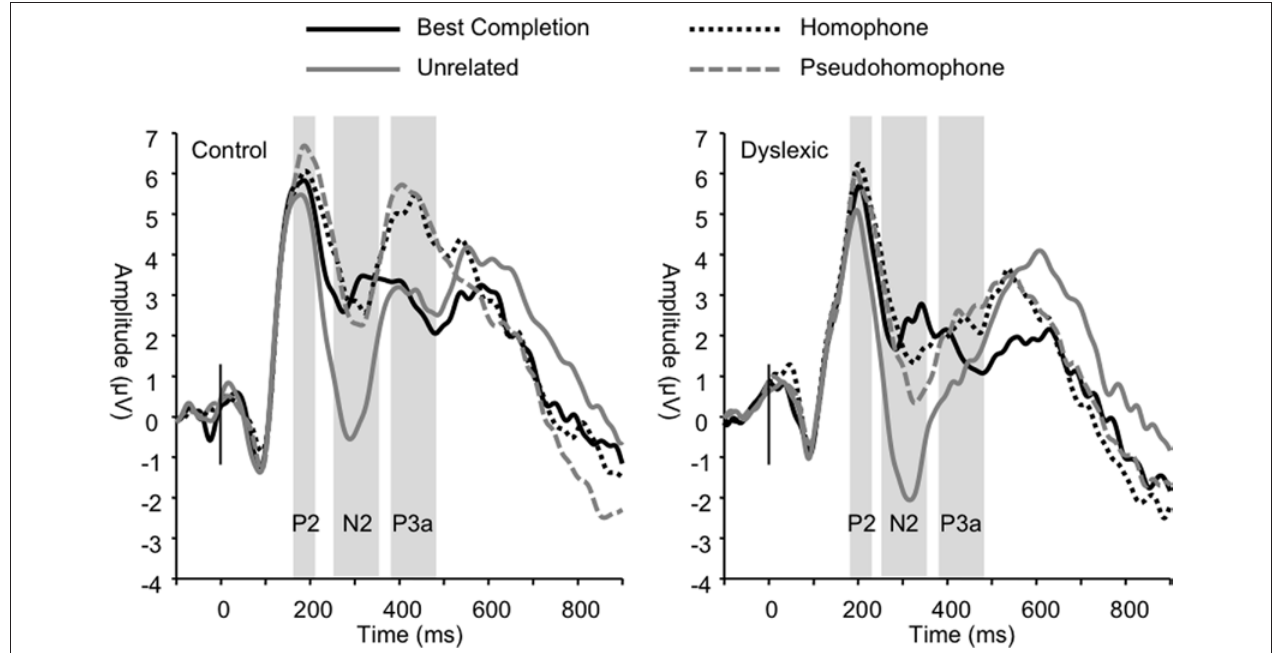
FiGure 4 | Group grand averages showing P2, N2, and P3a peaks based on a linear derivation of FC3, FC4, FCz, and Cz electrodes. Time windows for mean amplitude analyses are marked by the